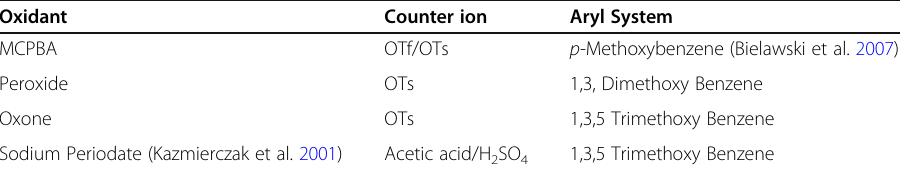
Table 2 Reaction conditions trialled with for iodonium salt synthesis Oxidant Counter ion Aryl System MCPBA OTf/OTs p -Methoxybenzene (Bielawski et al. 2007) Peroxide OTs 1,3, Dimethoxy Benzene Oxone OTs 1,3,5 Trimethoxy Benzene Sodium Periodate (Kazmierczak et al. 2001) Acetic acid/H 2 SO 4 1,3,5 Trimethoxy